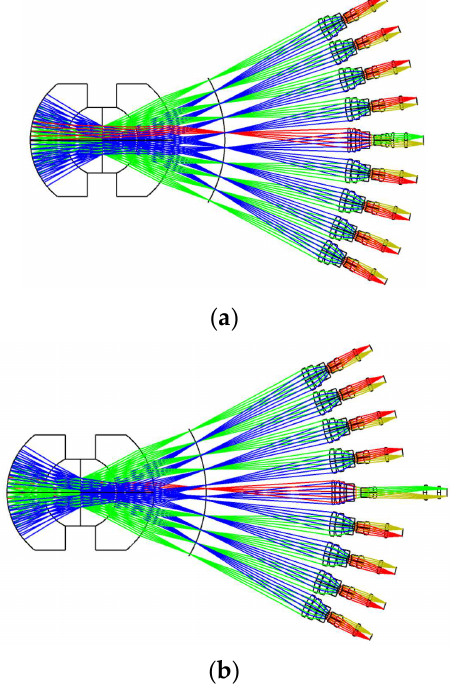
Figure 15. Configurations of the zoom concentric multi-scale optical system. ( a ) Central channel f = 50 mm, ( b ) Central channel f = 100 mm.